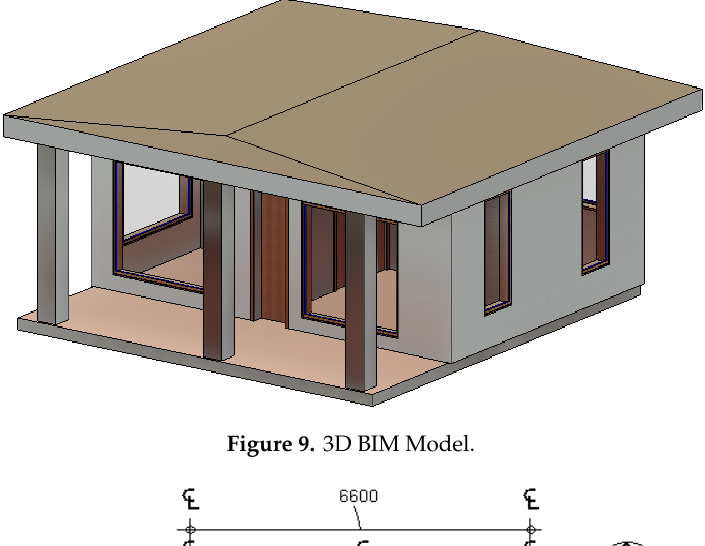
Figure 9. 3D BIM Model.